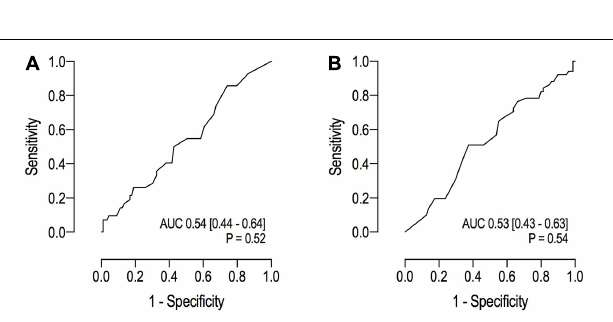
FIGURE 4 | (A) Receiver operating characteristic curves for ICU mortality; (B) Receiver operating characteristic curves for hospital